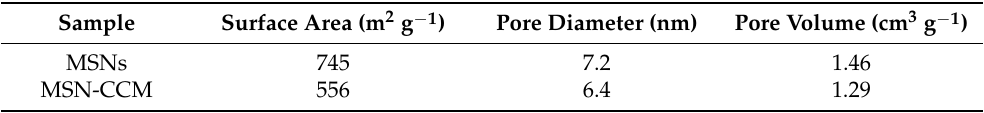
Table 1. Surface area, average pore diameter, and pore volume from N 2 adsorption–desorption isotherm measurements for MSNs and MSN-CCM.